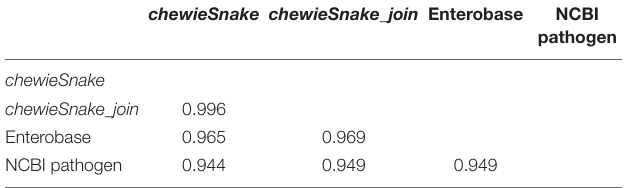
TABLE 2 | Discriminatory power according to adjusted Rand index.